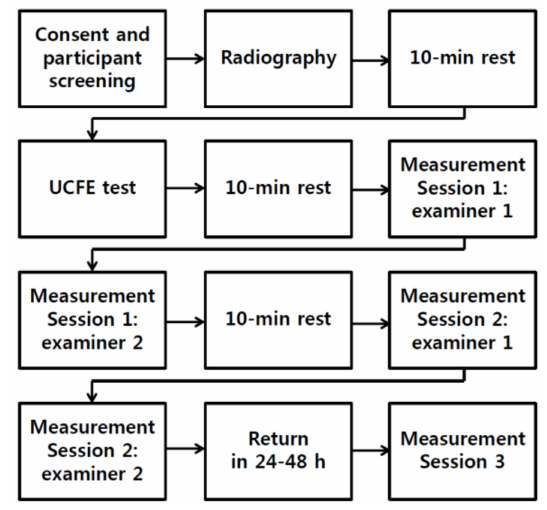
Figure 1. Flow chart of participant